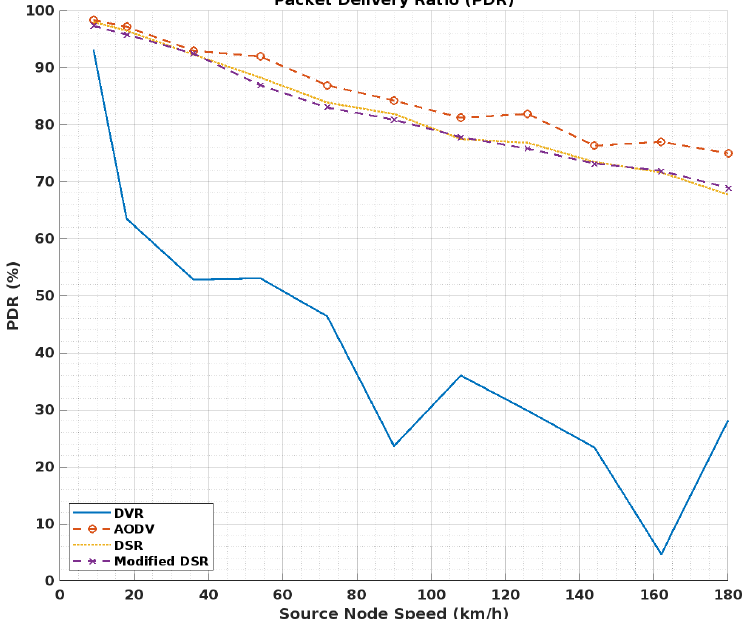
Figure 4. Packet delivery rate (PDR) as a function of the source node’s speed for the DVR, AODV, DSR, and Modified DSR protocols.